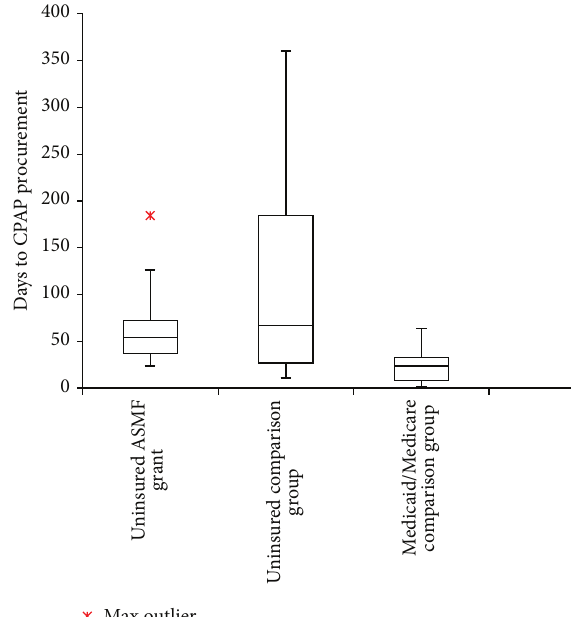
Figure 1: Time to procurement of CPAP devices in three groups: uninsured patients, uninsured patients funded by a charitable grant from the American Sleep Medicine Foundation, and those with government insurance (Medicaid/Medicare). Box and whisker plots of time to procurement of continuous positive airway pressure (CPAP) devices. The lower and upper limits of the boxes delineate the 25th and 75th percentile of the data, the whiskers show the 5th and 95th percentiles, and the horizontal lines show the median. Note the considerable time required for CPAP acquisition in those without insurance coverage, unsubsidized by charitable